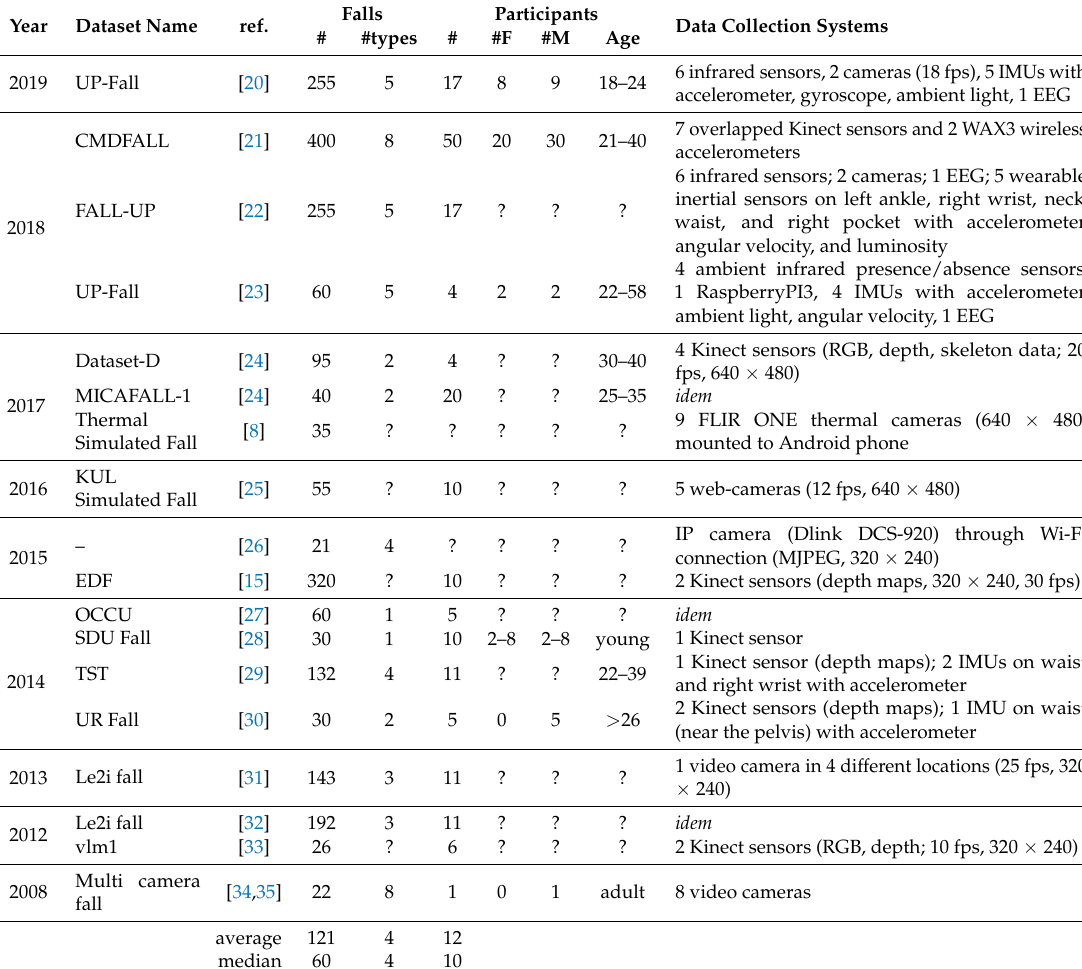
Table 2. Public datasets on falls obtained from ambient-based